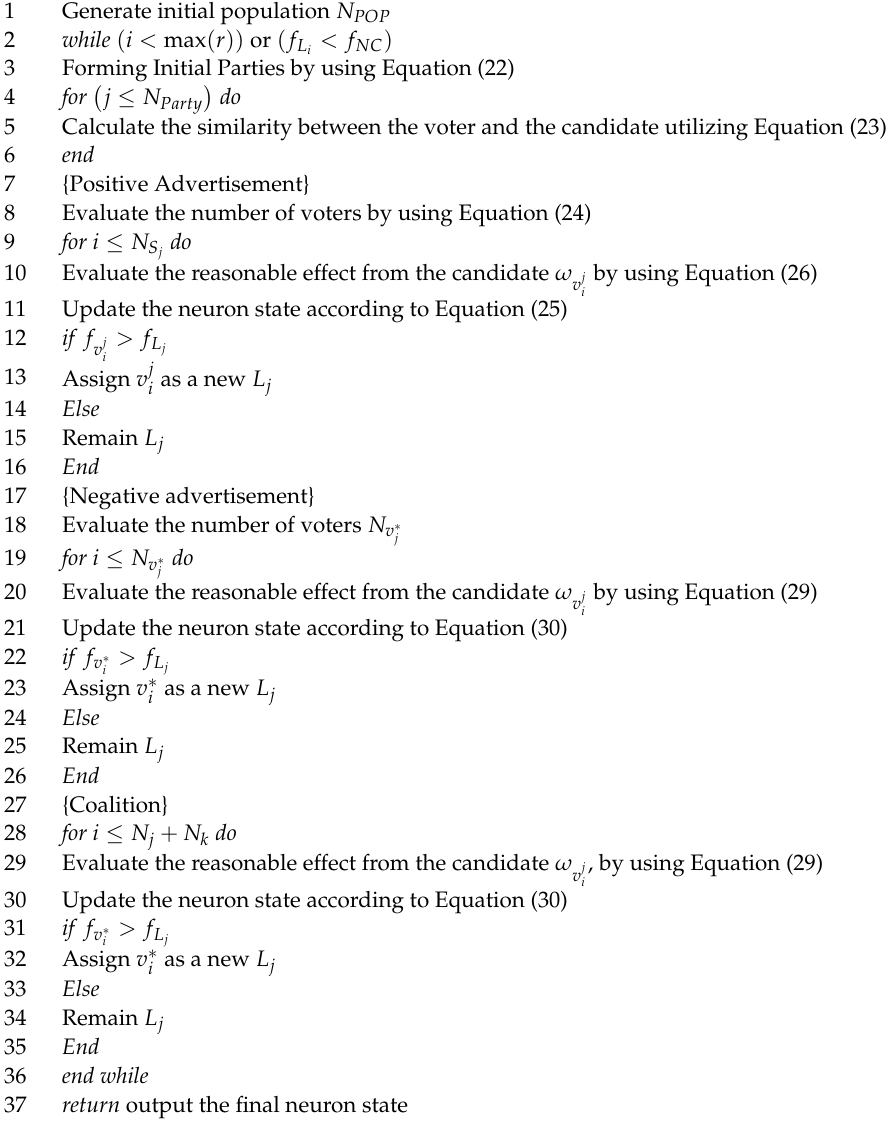
Algorithm 1: Pseudo Code of the Proposed